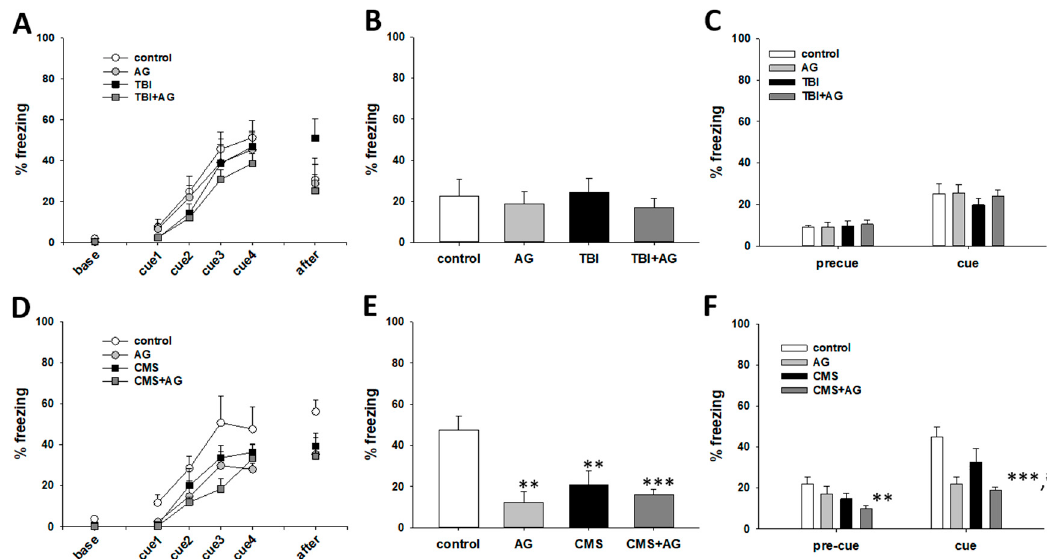
Figure 4. Fear memory by AG in TBI and CMS mice, as measured by the freezing time in the fear conditioning test. ( A ) Fear acquisition in the TBI model. There were time (within) effects [F(5,140) = 45.7, p < 0.001], treatment group (between) effects [F(3,28) = 3.25, p = 0.03], but no within–between interaction differences [F(15,140) = 1.1, p = 0.36]. There were no differences between the treatment groups at base, cue1, cue2, cue3, or cue4. However, the differences between the TBI and TBI + AG groups were significant ( p = 0.039). In addition, the differences between the TBI and control groups ( p = 0.16), and TBI vs. AG ( p = 0.13) groups were not significant. ( B ) Consolidated contextual fear memory in TBI model. There were no group differences in the freezing response to the context [F(3,28) = 0.36, p = 0.78). ( C ) Consolidated cued fear in the TBI model. There were procedure (within) effects [F(1, 28) = 61.6, p < 0.001], no treatment group (between) effects [F(3,28) = 0.29, p = 0.83], or within–between interactions [F(3,28) = 0.64, p = 0.59]. There was a significant increase in the freezing comparing cue vs. precue in the control ( p < 0.001), AG ( p < 0.001), TBI ( p = 0.005), and TBI + AG groups ( p < 0.001). ( D ) Fear acquisition in the CMS model. There were time (within) effects [F(5,95) = 27.8, p < 0.001], treatment group (between) effects [F(3,19) = 4.9, p = 0.011], but no within–between interaction effects [F(15,95) = 0.47, p = 0.95]. Fear acquisition in AG ( p = 0.021), CMS ( p = 0.035), and CMS + AG ( p = 0.001) were lower than controls throughout the fear acquisition procedure. There were no statistical differences among the AG, CMS, and CMS + AG groups. ( E ) Consolidated contextual fear memory in the CMS model. There were group differences in the freezing response to the context [F(3,19) = 9.8, p < 0.001). The contextual fear in AG ( p = 0.002), CMS ( p = 0.008), and CMS + AG ( p < 0.001) was lower than those of the controls. ( F ) Consolidated cued fear in the CMS model. There were procedure (within) effects [F(1,19) = 54.7, p < 0.001], treatment group (between) effects [F(3,19) = 9.3, p = 0.001], and within–between interaction differences [F(3,19) = 4.8, p = 0.012]. There was a significant increase in freezing between cue and precue in the control ( p < 0.001), CMS ( p < 0.001), and CMS + AG ( p = 0.002) groups, but not in the AG group ( p = 0.31). At pre-cue, the control vs. CMS + AG ( p = 0.001) groups were statistically different. At cue, the control vs. AG, ( p = 0.004); control vs. CMS + AG, ( p < 0.001); CMS vs. CMS + AG, ( p = 0.017) were all statistically different. All data were normally distributed and are represented as means ± S.E.M. Control: vehicle (DW) treated; AG: Angelica gigas 1 mg/kg; TBI: vehicle treated + traumatic brain injury; TBI + AG: Angelica gigas 1 mg/kg + traumatic brain injury; CMS: vehicle treated + chronic mild stress; CMS + AG: Angelica gigas 1 mg/kg + chronic mild stress. ** p < 0.01, *** p < 0.001 vs. control. # p < 0.05 vs. CMS. ANOVA and repeated measures ANOVA, Tukey’s HSD post-hoc test.